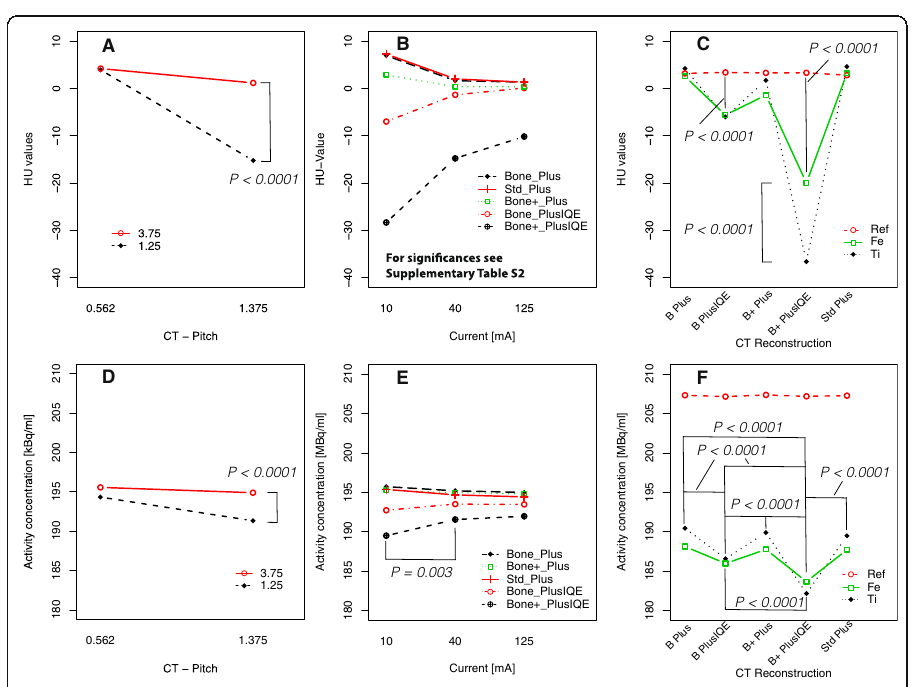
Fig. 5 Interaction plots illustrating the effect from a , d pitch and reconstructed slice thickness, b , e X-ray tube current and CT-reconstruction/filter setup, c , f analyzed region and CT-reconstruction/filter setup. Effects are shown for a ‑ c HU values and d ‑ f corresponding reconstructed activity